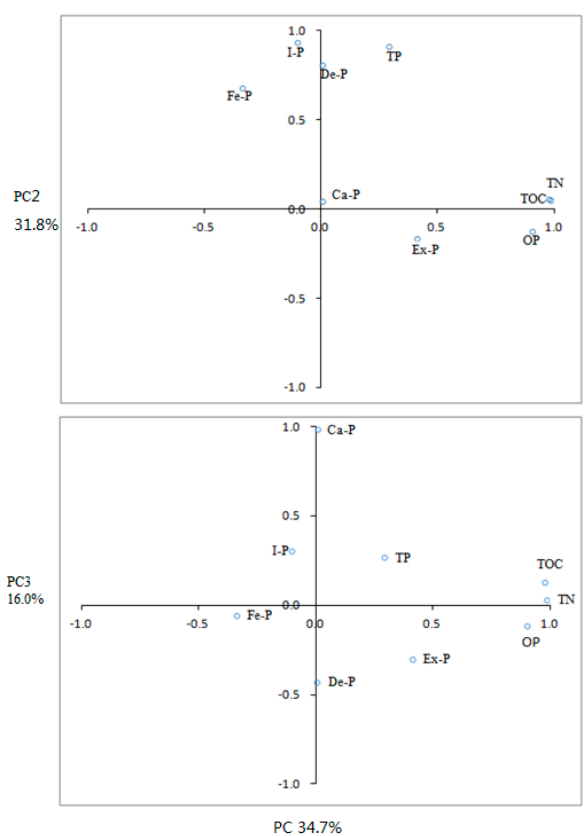
Figure 5. PCA loadings (PC1 versus PC2 and PC3) for different P fractions, TN and TOC in surface sediments.